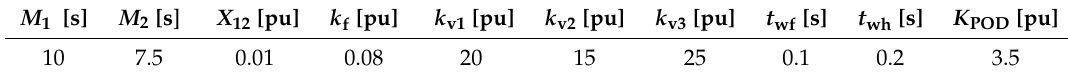
Table 1. AC system and HVDC control parameters.